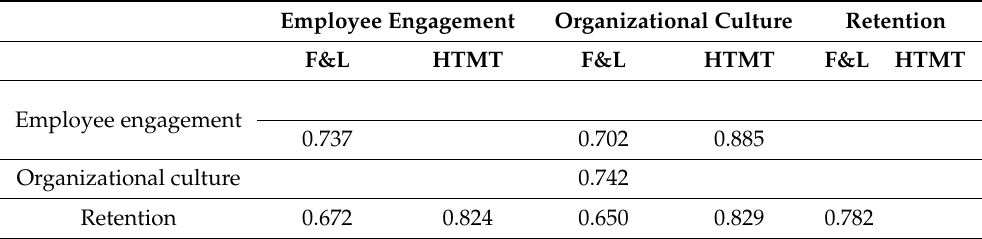
Table 3. Discriminant validity.